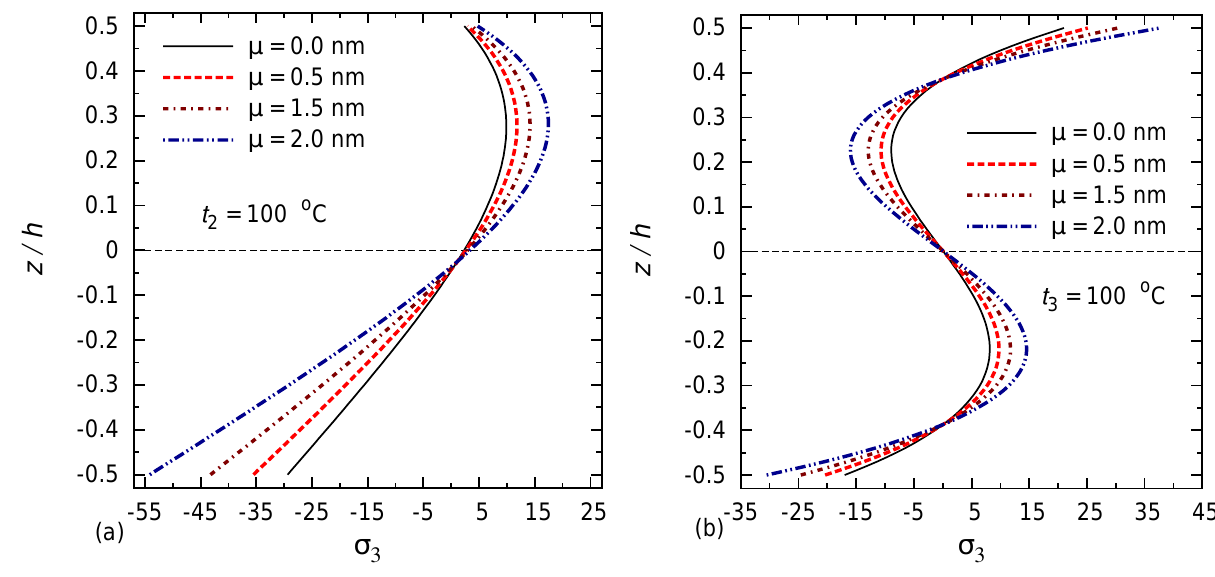
Figure 7. Effect of the nonlocal coefficient µ on the transverse normal stress σ 3 through-the-thickness of FG square nanoplates ( a ) t 2 = 100, t 3 = 0 and ( b ) t 2 = 0, t 3 = 100 ( a = 10 h , κ 1 = κ 2 = 10 ) .